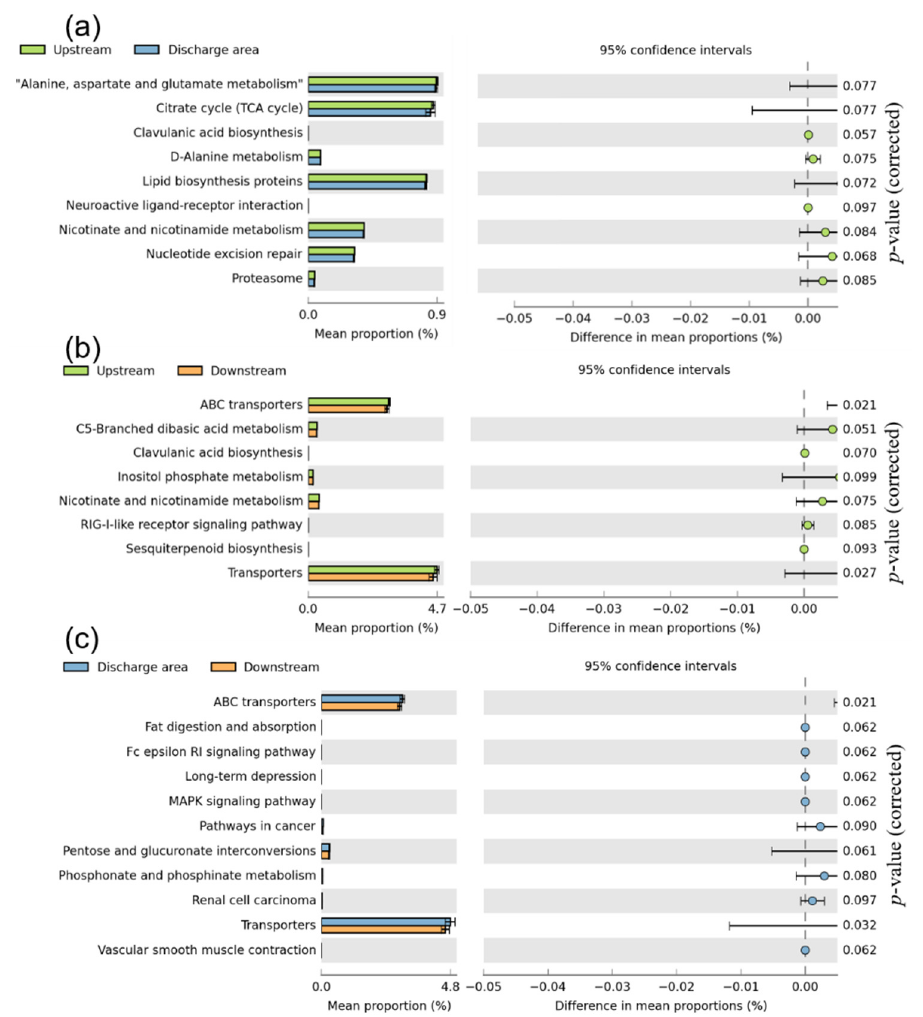
Figure 5. Significant differences in bacterial function predicted by PICRUSt within Kyoto Encyclo- pedia of Genes and Genomes (KEGG) grouped into level-3 functional categories between ( a ) the Upstream group and Discharge area group, ( b ) the Discharge area group and Downstream group, ( c ) the Discharge area group and Downstream group, using the response ratio method at a 95% confidence